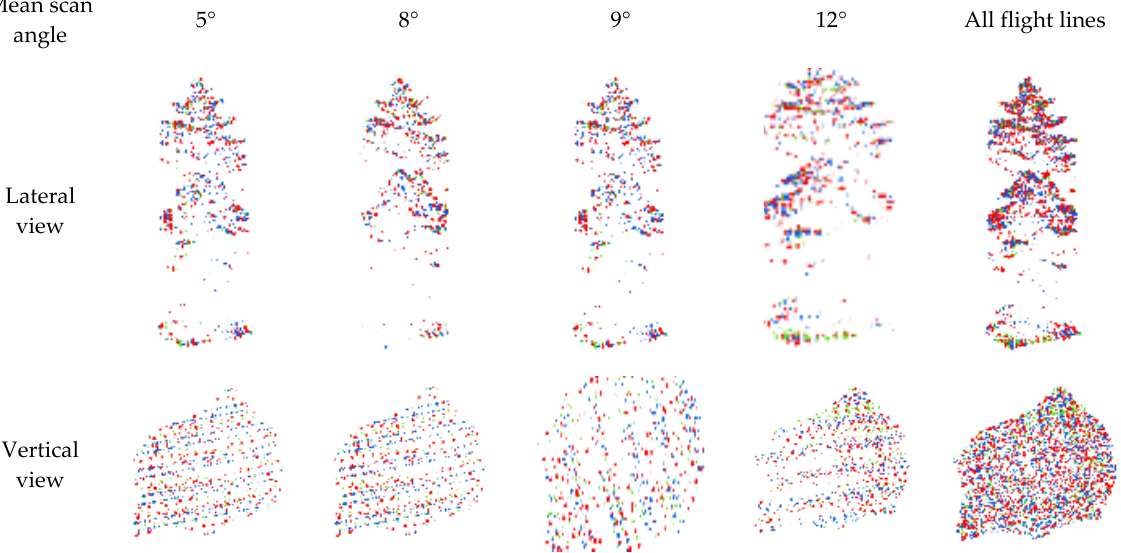
Figure 2. Example of the point cloud of a Pinus resinosa tree as seen from four different flight lines with respective scan angles of 5°, 8°, 9° and 12° (i.e., four tree views), and a combination of the point clouds from all four flight lines. Mean scan angle of the individual tree views was calculated from C2. Legend: red = C1, blue = C2, green = C3; point size is a function of intensity. The 3D and intensity features were computed for each reference tree. Several ver- sions of each feature were computed from the point cloud that was extracted for each channel of each tree view. A feature version corresponds to one of three return types: all returns (all); first returns (1st); and single returns (si). A variable threshold for each tree was used to remove potential ground and understory points by retaining only returns that were greater than 40% of the height of the reference trees.